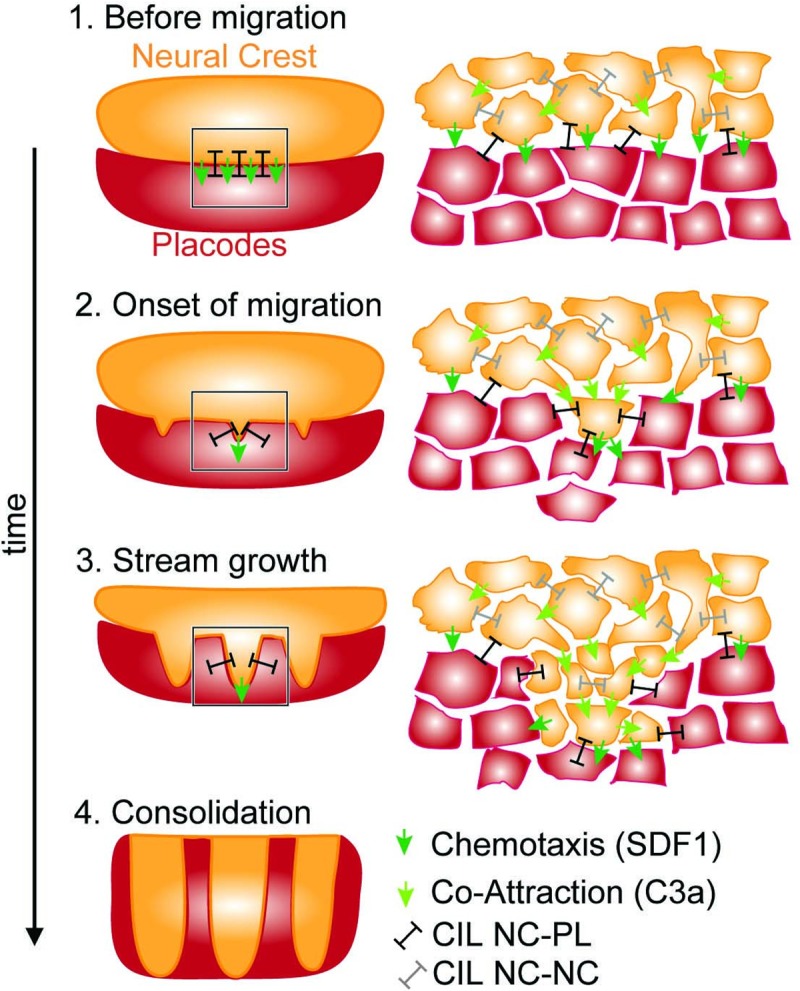
Model for emergent stream formation of the neural crest based on cellular chase and run interaction between the neighboring NC and placode populations.The gross tissue pattern (left) is determined by dynamic cell-cell interactions (right) without the need for a guiding pre-pattern to determine areas of stream growth. Consolidation of the final stream shapes at later stages are potentially facilitated by other mechanisms to ensure proper integration of the NC with other tissues.